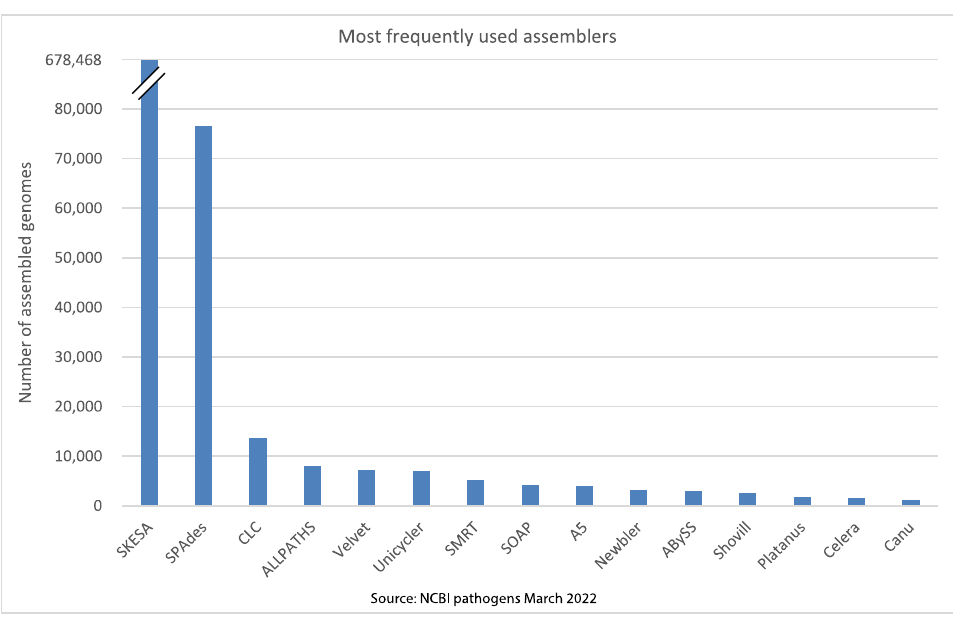
Figure 3. Most of the commonly used assemblers reported in the NCBI bacterial pathogens database as of March 2022.